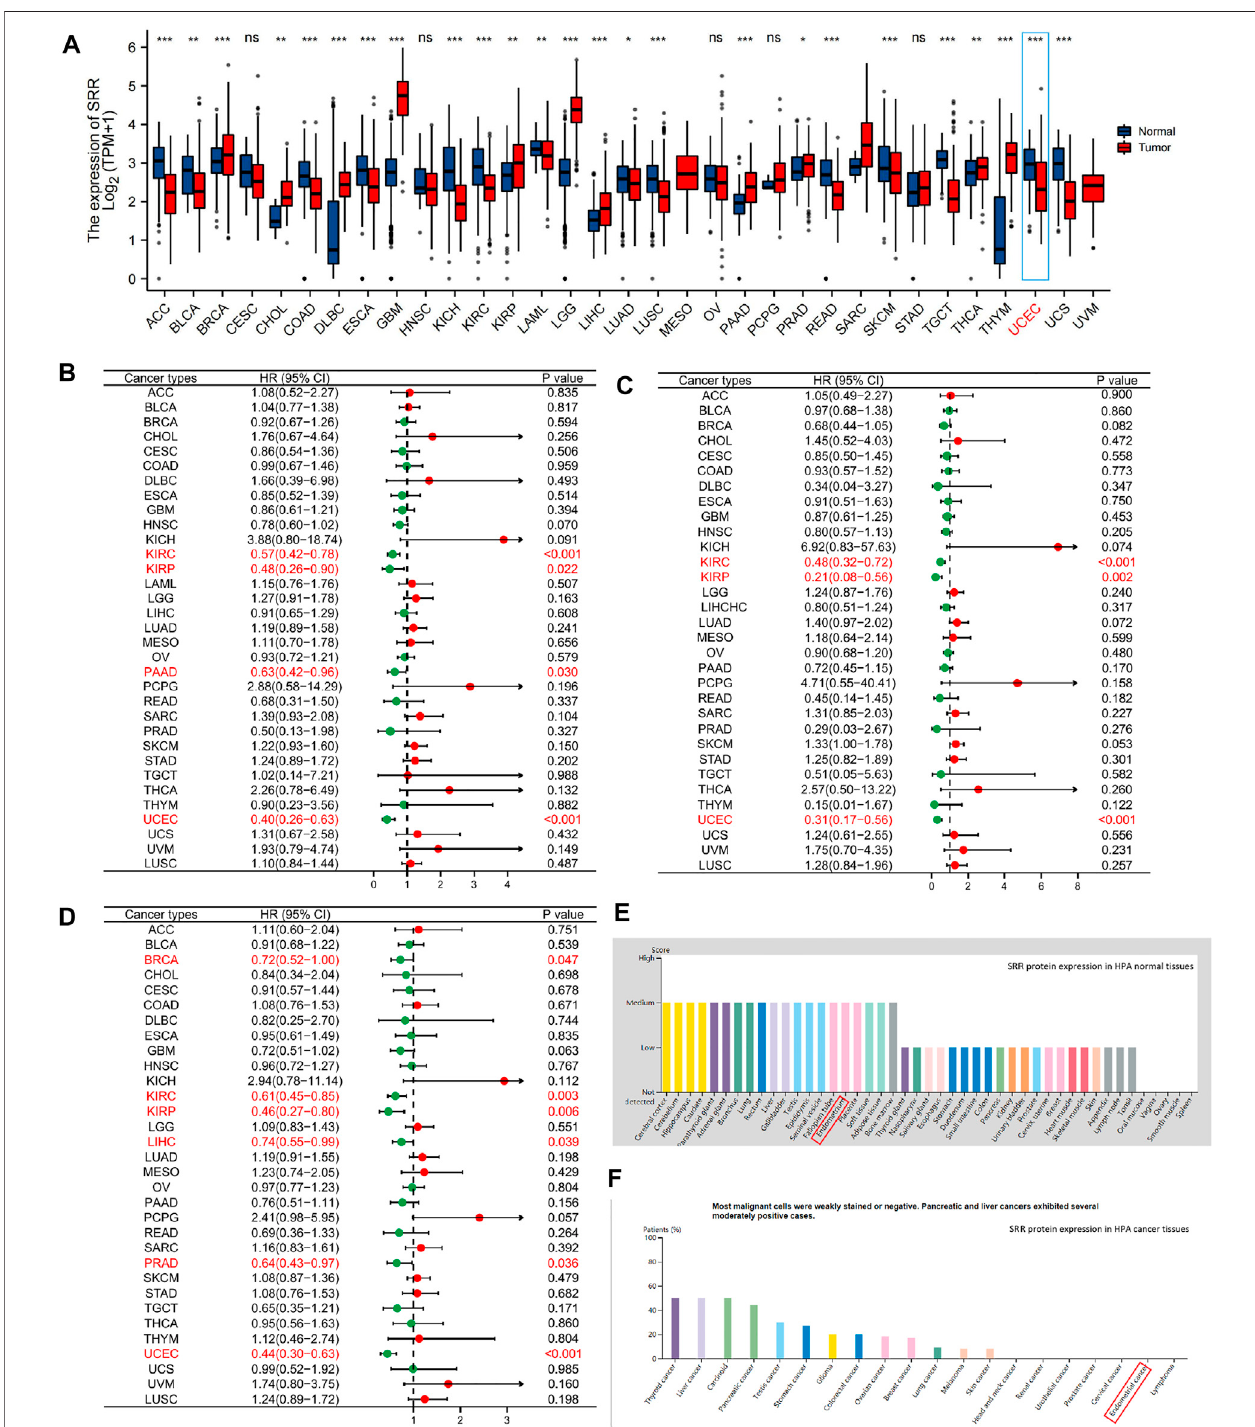
FIGURE 1 | Pan-cancer expression and survival analysis of SRR. (A) SRR mRNA expression levels in different types of cancer and their corresponding normal tissues. (B) Forest plot demonstrating the relation between SRR expression and OS. (C) Forest plot demonstrating the relation between SRR expression and DSS. (D) Forest plot demonstrating the relation between SRR expression and PFI. (E) SRR protein expression in HPA human normal tissues. (F) SRR protein expression in HPA human cancer tissues. In (A) , * indicates p < 0.05, ** indicates p < 0.01, *** indicates p < 0.001, ns denotes not signi fi cantly different. In (B – D) , red dots represent HR > 1, green dots represent HR <